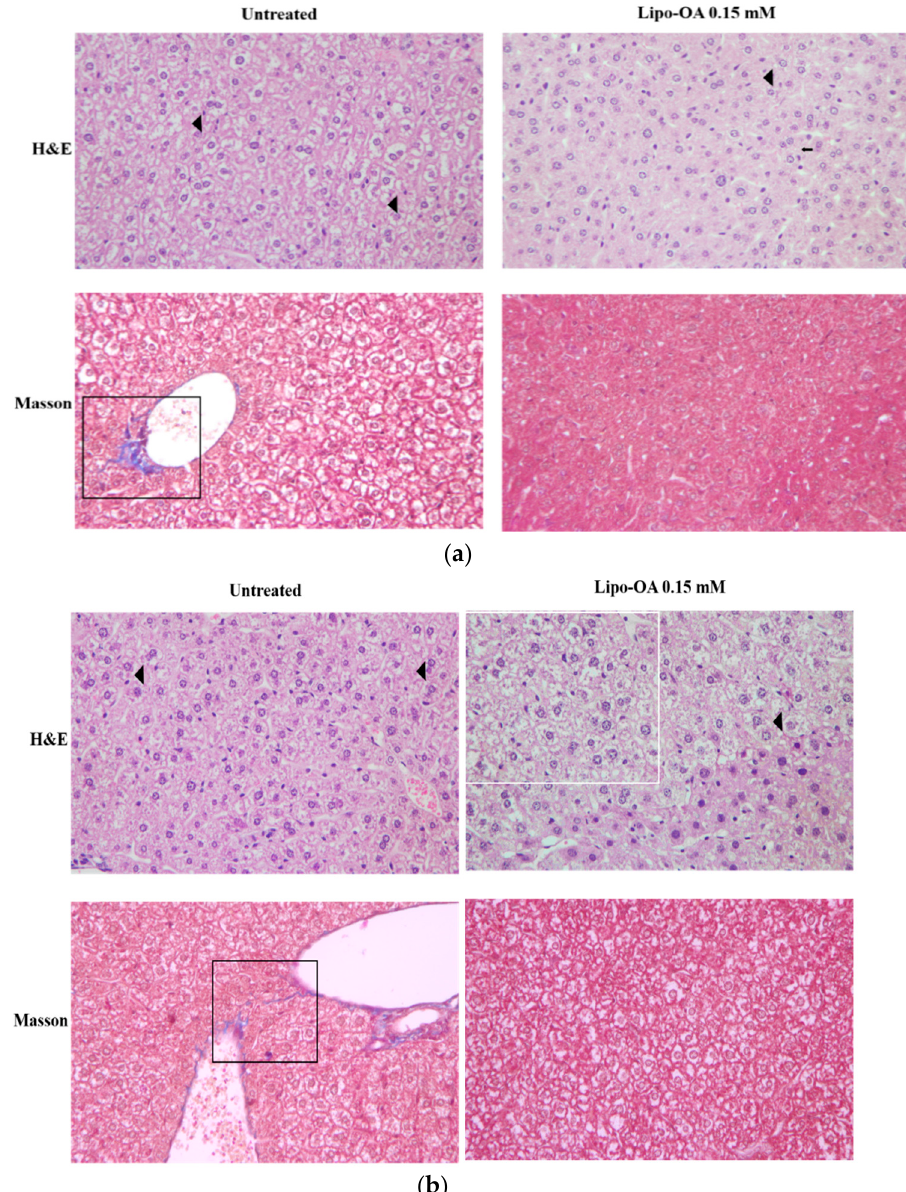
Figure 6. HE staining and Masson’s trichrome staining of the sections of PM 2.5 and alcohol-induced